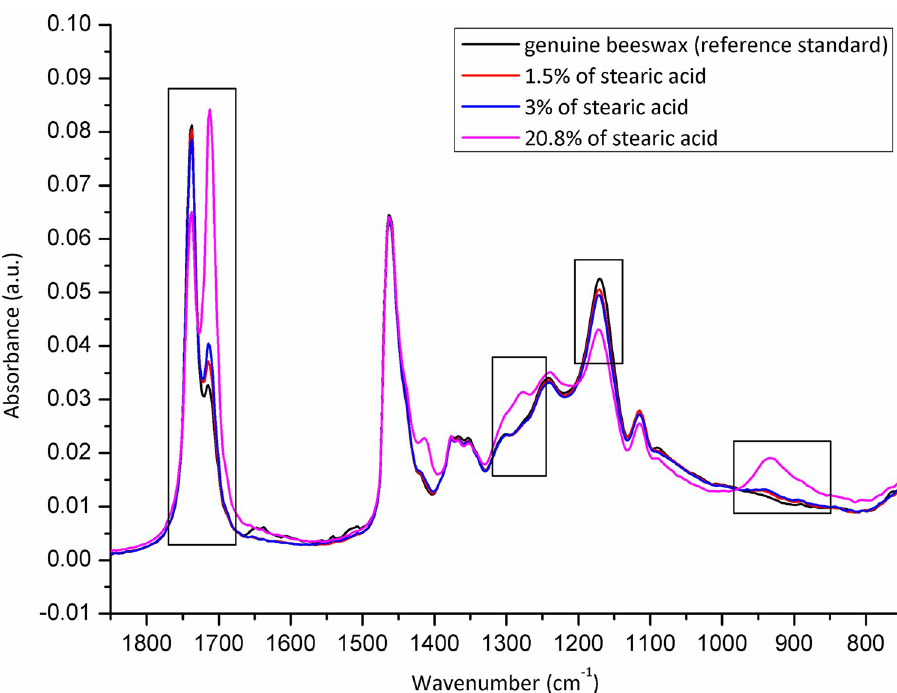
Fig 15. Comb foundation samples adulterated with stearic acid (N = 3) versus genuine beeswax (reference standard) with an emphasis on spectral regions indicative for adulteration detection. Wavenumber, the number of waves per unit distance; cm, centimetre; a.u. is for the absorbance unit.